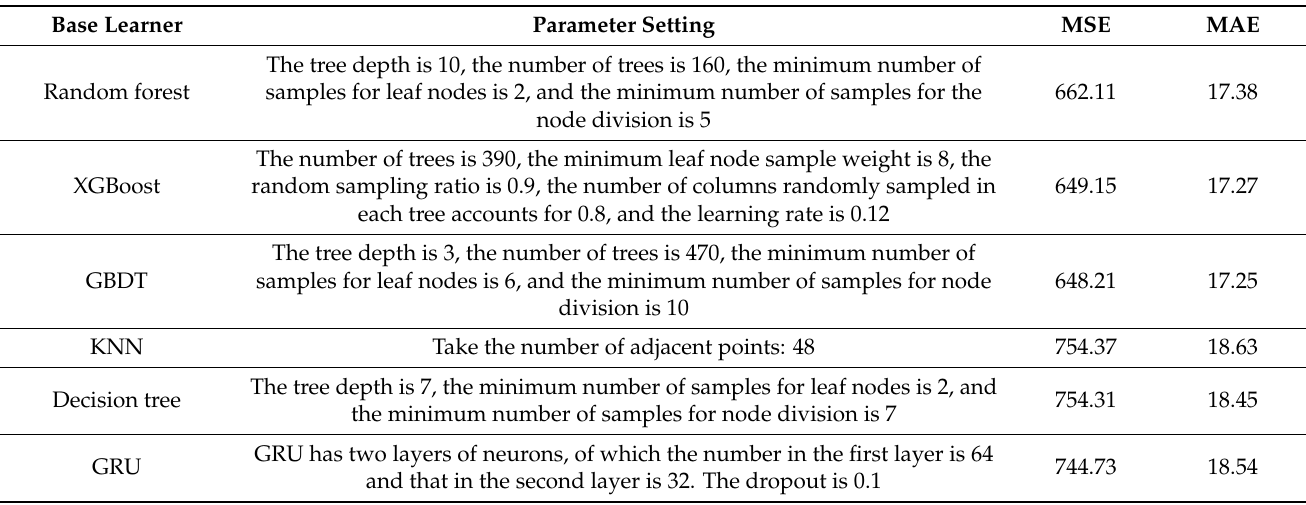
Table 2. The single model